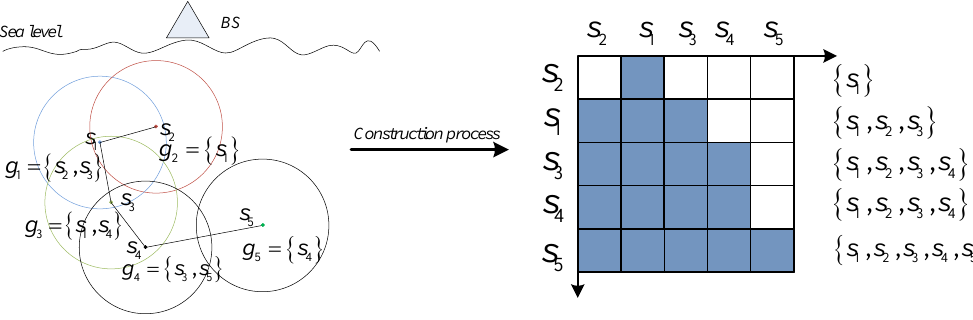
Figure 4. An example of information pool construction (no isolated